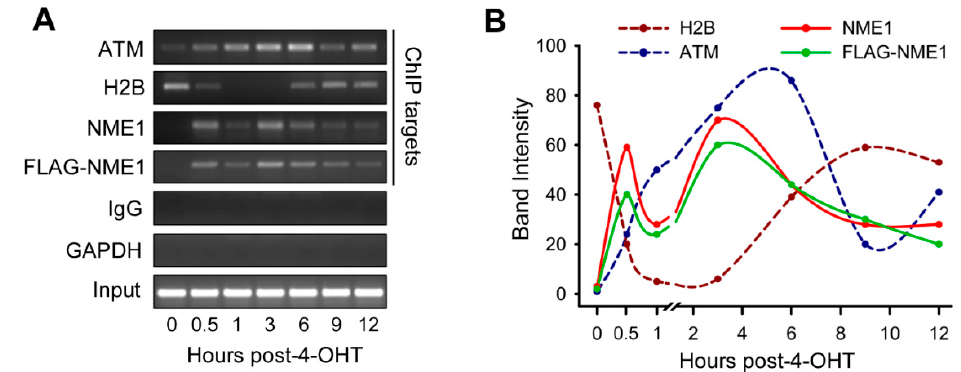
Figure 2. NME1 is recruited to double-strand breaks in DNA. ( A ) Analysis of chromatin immunoprecipitation (ChIP) DNA products by agarose gel electrophoresis and ethidium bromide staining. WM793 FLAG-NME1 cells were infected with HA-ER-I-PpoI retrovirus and treated with 1 µ M 4-OHT treatment for 15 min to induce translocation of I-PpoI into the nucleus. Cells were fixed at the indicated time points and ChIP performed using the indicated antibodies. Primers directed to the 28S rDNA I-PpoI target site were used, or directed to GAPDH as a negative control. Results shown are representative of two replicate experiments. ( B ) Quantification of bands in panel A using ImageJ for densitometry [32]. Band intensity values ( Y -axis) corresponding to degree of relative brightness compared to background on a scale of